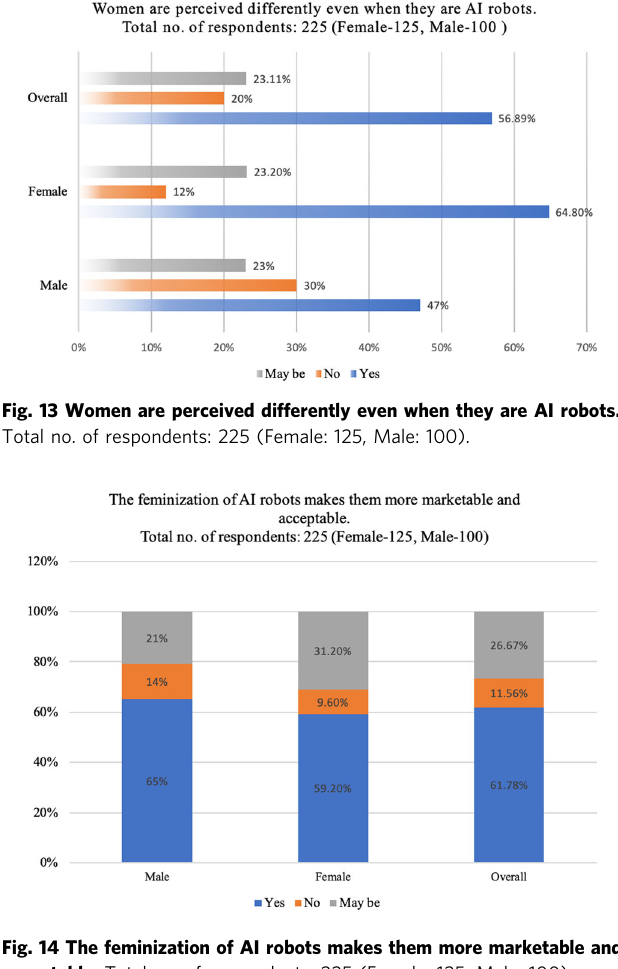
Fig. 15 Feminity is being used to humanize non-human creatures such as AI robots. Total no. of respondents: 225 (Female: 125, Male: 100).